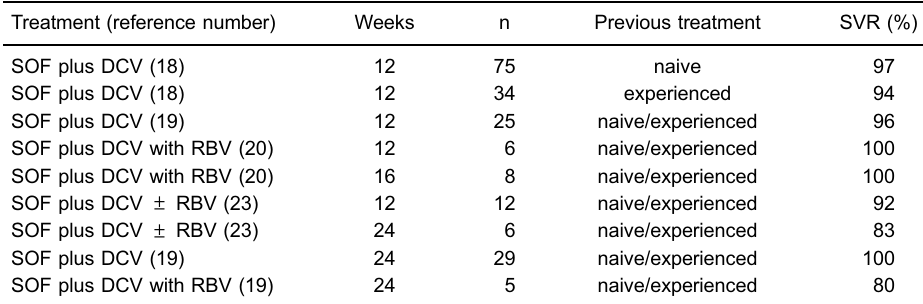
Table 2. Summary of sustained virological response (SVR) rates in non-cirrhotic patients with hepatitis C virus (HCV) genotype 3 infection treated with sofosbuvir (SOF) plus daclatasvir (DCV) with or without ribavirin